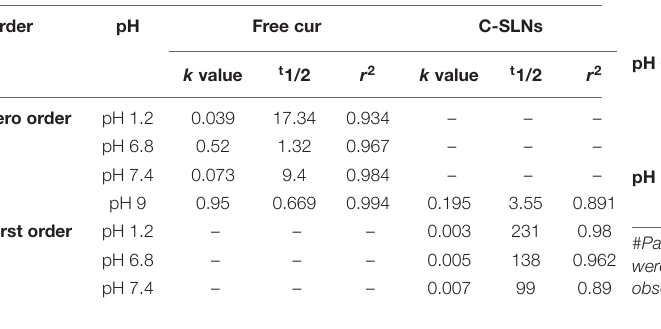
TABLE 3 | Various degradation kinetics parameters for free curcumin and CLEN ( n = 6).